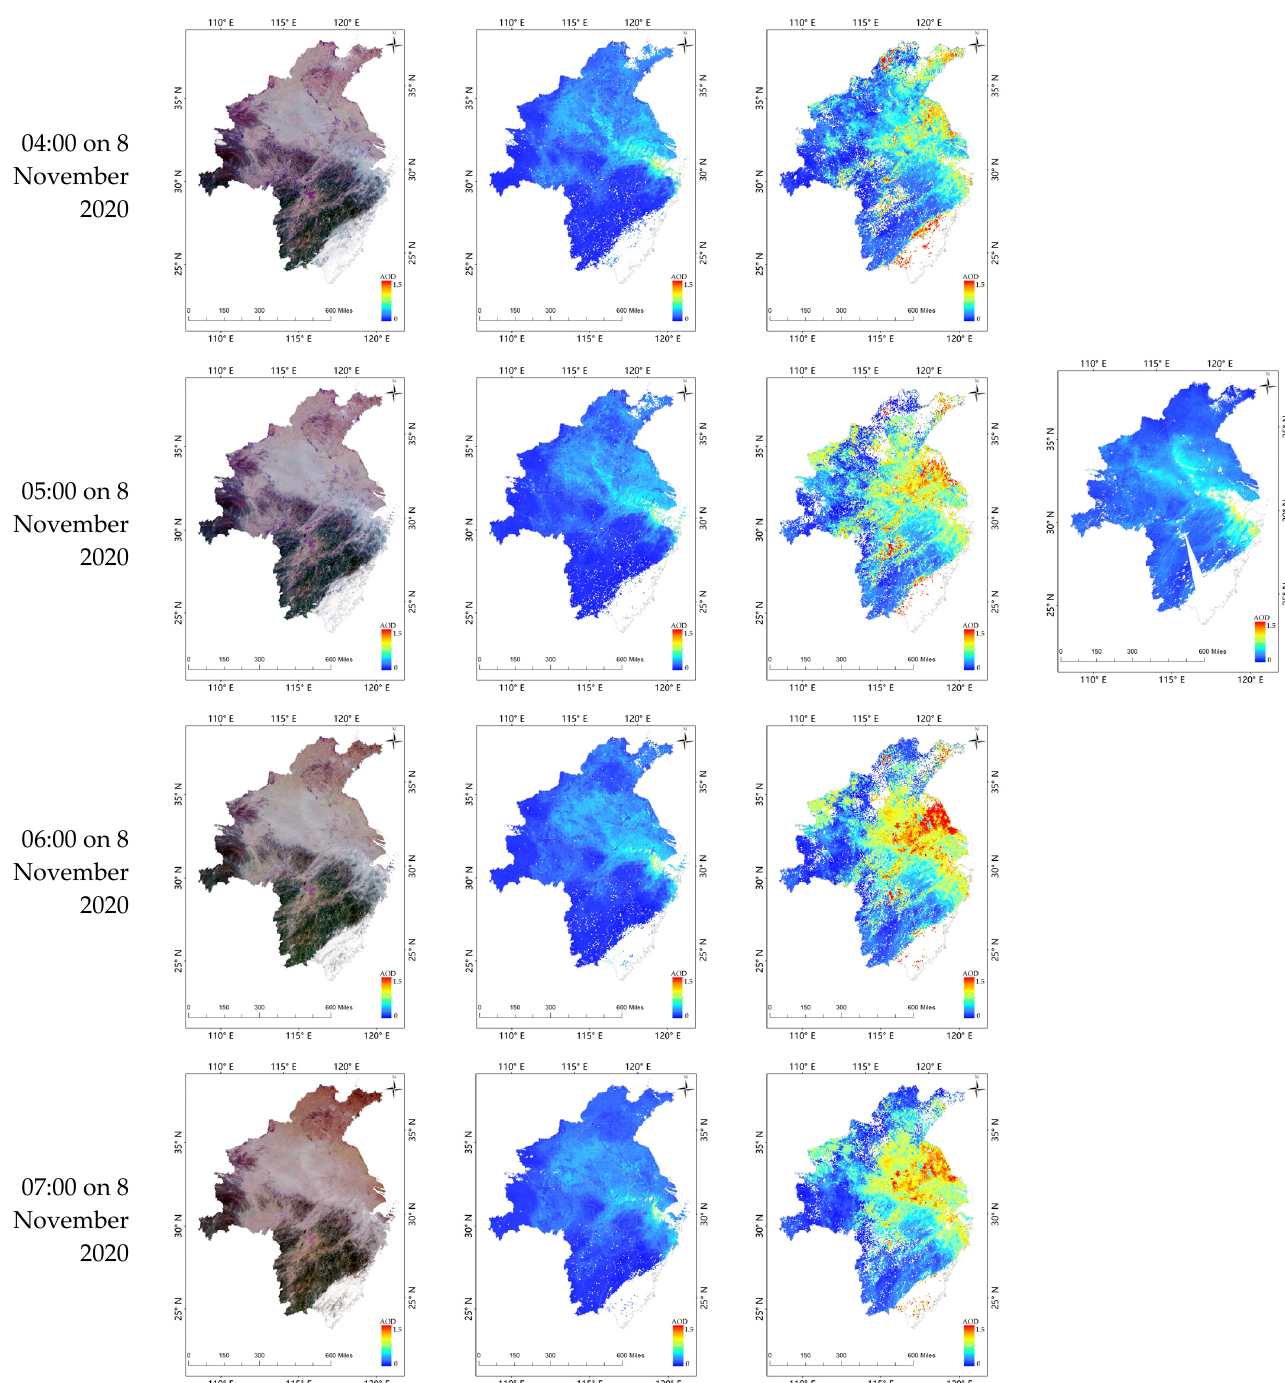
Figure 8. Hourly AHI true-color RGB images (1st column of panels), DNN-estimated AHI AOD (2nd column of panels), AHI AOD products (3rd column of panels) and MODIS AOD products (4th column of panels) over Eastern China at 1:00~7:00 (top to bottom) on 8 November 2020.